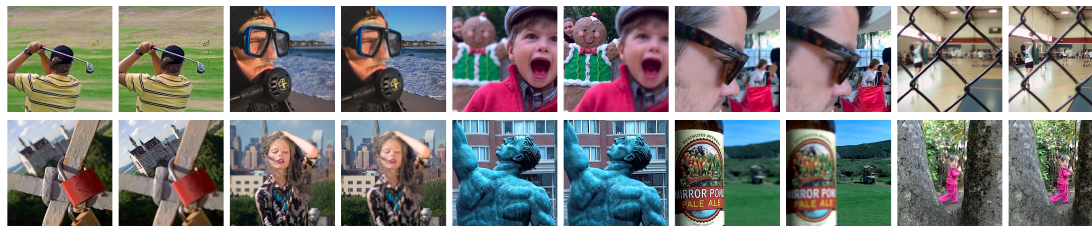
Figure 4. Sample images from Lytro multi-focus image fusion